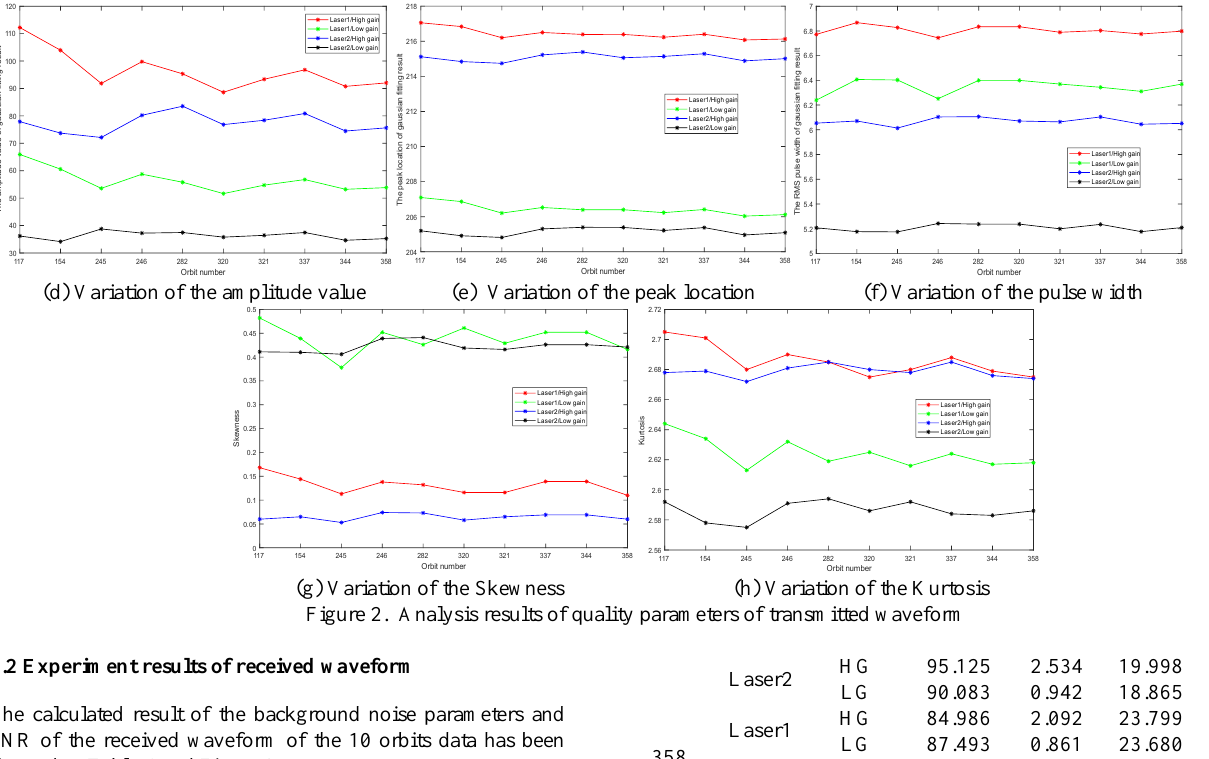
Figure 2. Analysis results of quality parameters of transmitted waveform